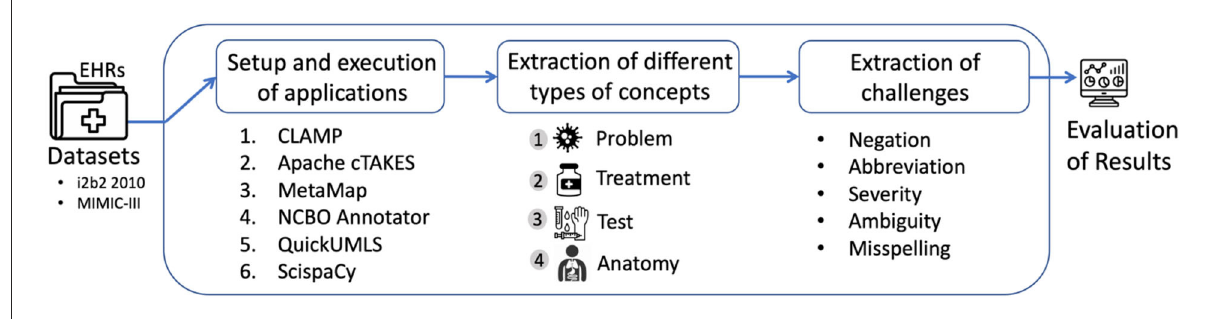
FIGURE1 Workflow of the comparison of concept recognition systems across different tasks.